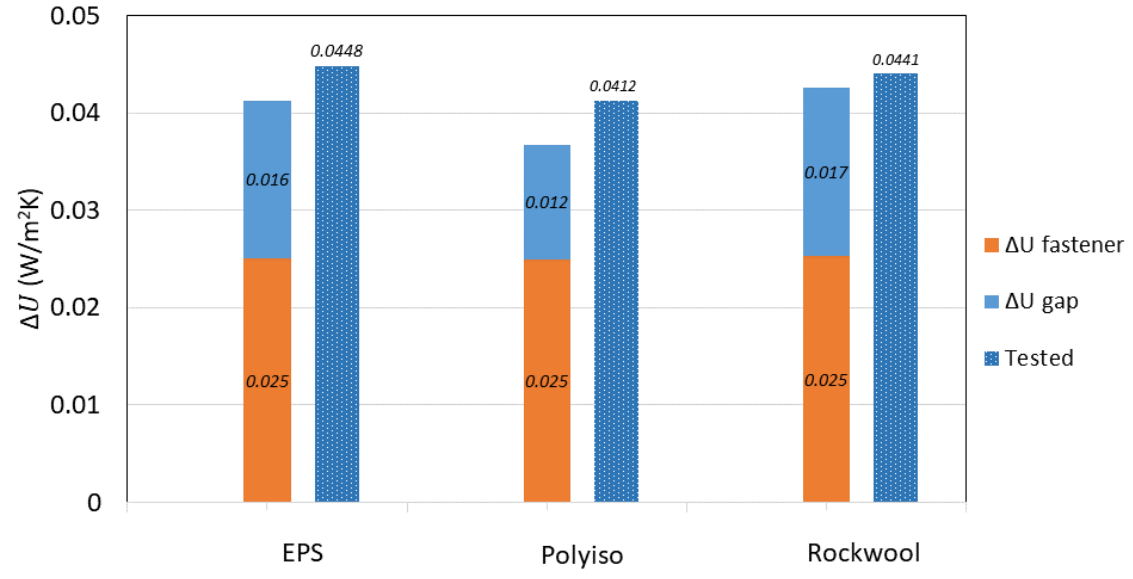
Figure 12. Fasteners and Gaps: Comparison of the Calculated and Tested Thermal Transmittance,